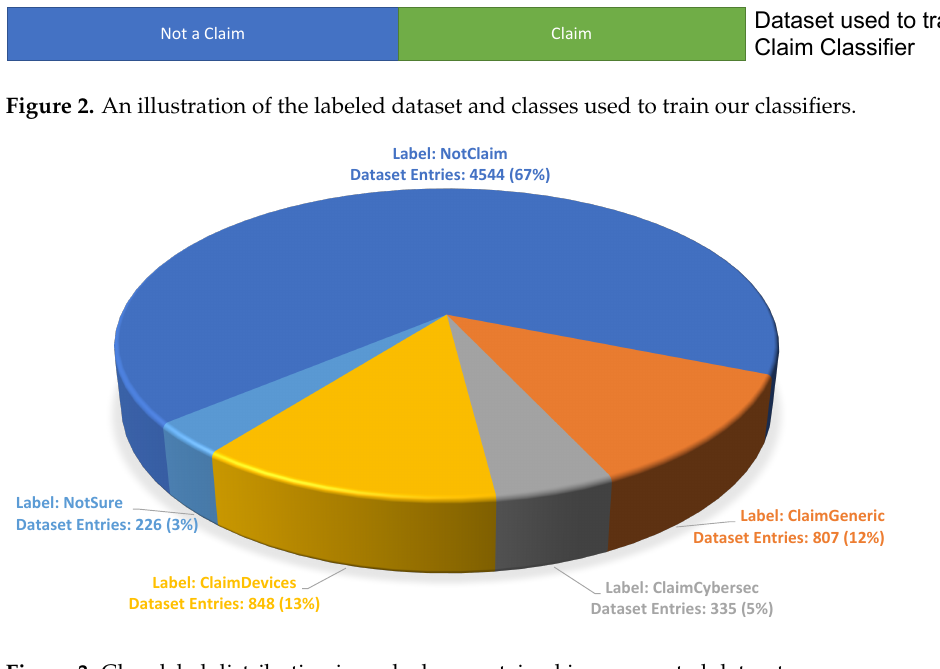
Figure 3. Class label distribution in each class contained in our curated